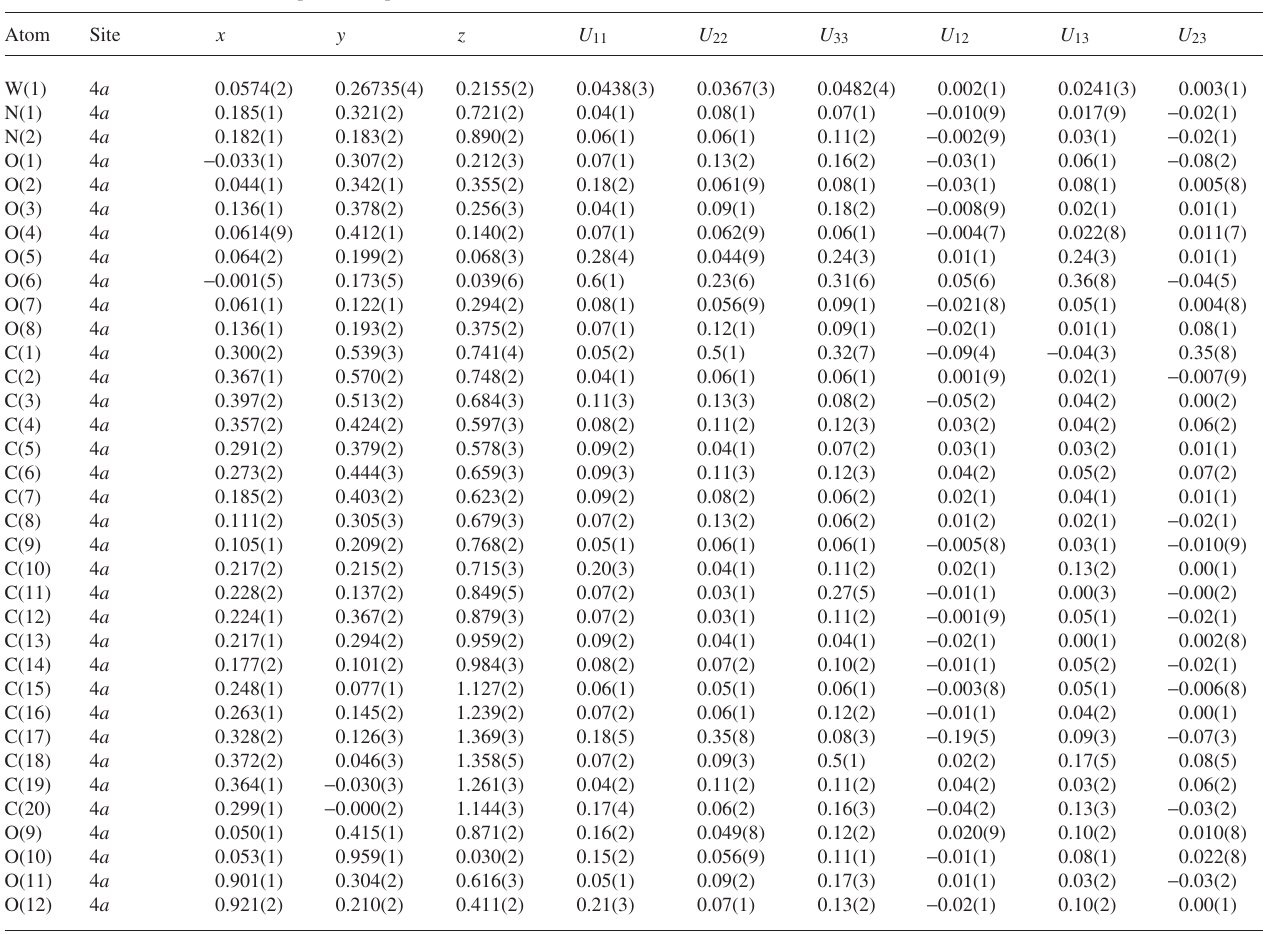
Table 3. Atomic coordinates and displacement parameters (in Å 2 )